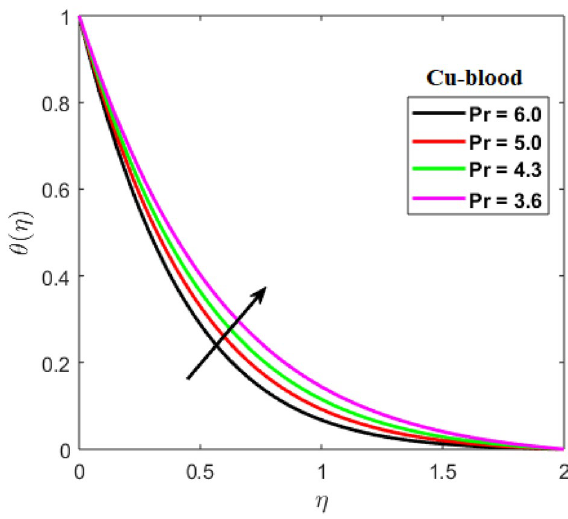
Figure 5. Profile of Pr for temperature.